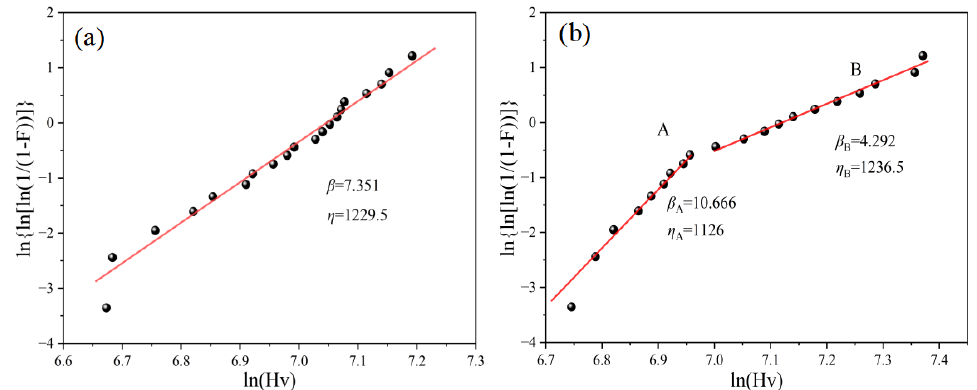
Figure 8. Weibull distribution of the hardness test values of ( a ) micron Al 2 O 3 coating ( b ) nano Al 2 O 3 coating.